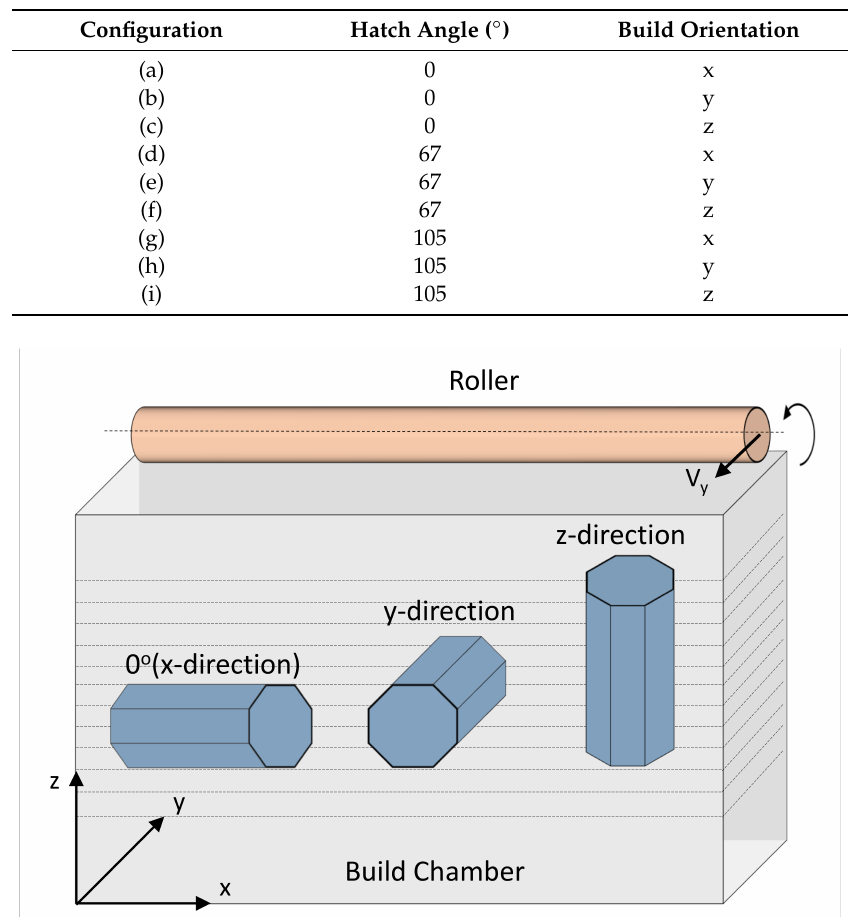
Figure 3. Schematic view of build orientations for manufacturing SLM